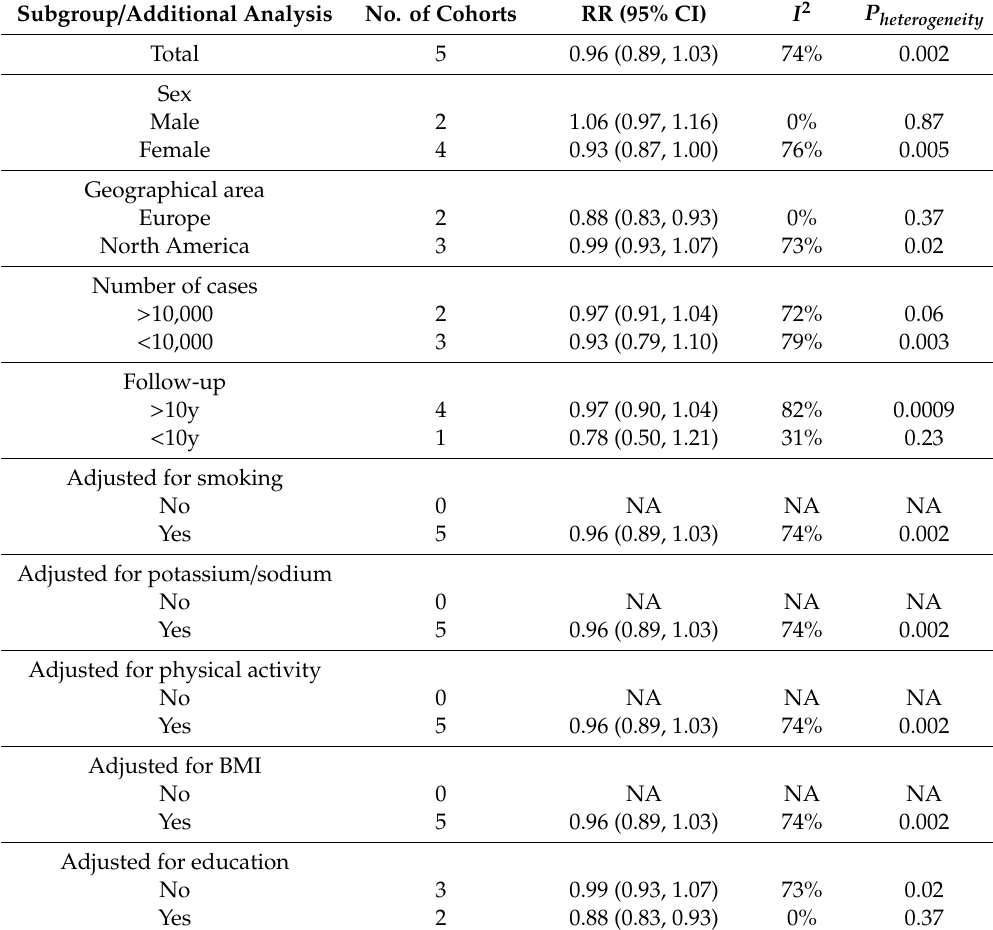
Table 2. Subgroup analyses of studies reporting risk of hypertension for the highest versus lowest (reference) category of dietary